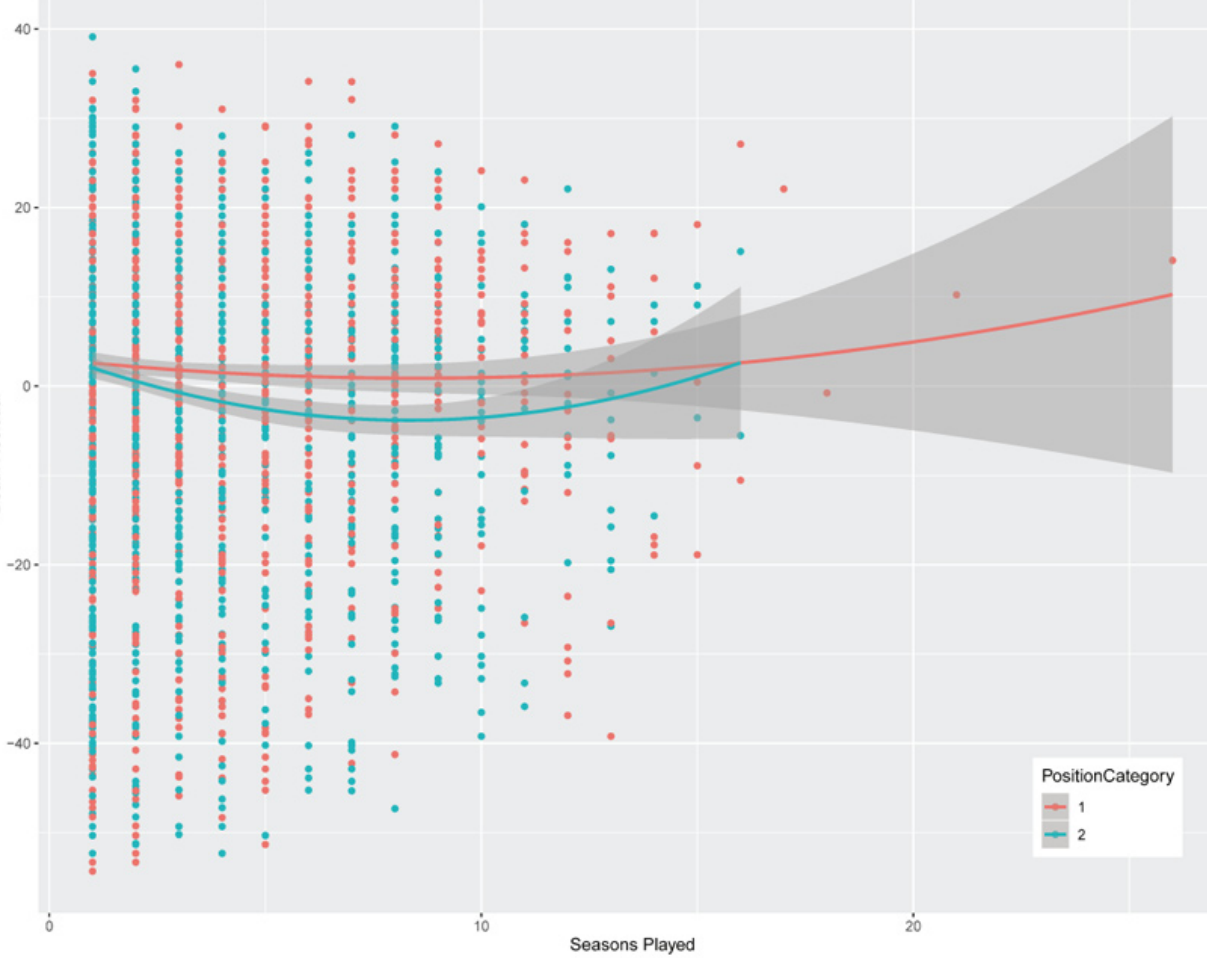
Figure 1b. Age-at-death residual versus seasons-played for category 1 and 2 deceased National Football League (NFL) players (1922–2018) N=3,290. Dots represent individual players; Solid line represents a quadratic